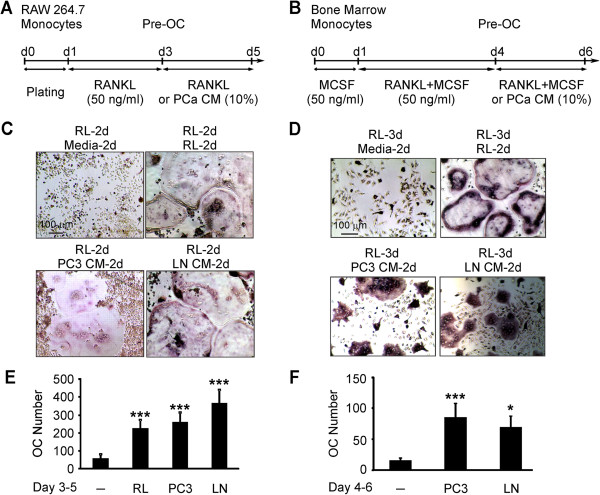
Soluble factors produced by prostate cancer cells increase osteoclast formation from RANKL-primed precursors. A, B) Schematic overviews of experimental setup for osteoclastogenesis assay, from (A) RAW 264.7 and (B) bone marrow cells. RAW 264.7 monocytes were first primed with 50 ng/ml RANKL (RL) for 2 days, and bone marrow cells for 3 days; then the osteoclast precursors (Pre-OC) were cultured untreated (negative control), treated with RANKL (positive control), or supplemented with 10% PC3 or LNCaP CM. C, D) Representative images of osteoclasts formed in different conditions from RAW 264.7 (C), and bone marrow (D) cells. E, F) Average osteoclast numbers formed in different conditions from RAW 264.7 (E) and bone marrow (F) cells. Data are means ± SEM; n = 10 experiments for RAW 264.7 cells, n = 7 for bone marrow cells; *P < 0.05, ***P < 0.001 indicate significance compared to negative control as assessed by Student’s t-test.